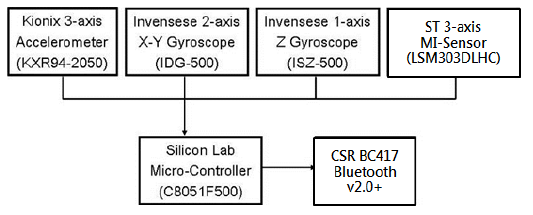
Figure 1. The block diagram of the developed inertial sensor module